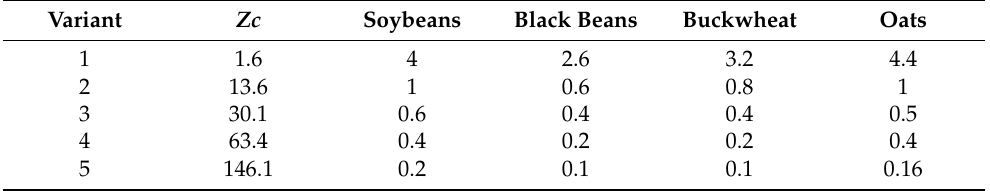
Table 8. The biological absorption coefficients of lead for all crops and the total pollution index.